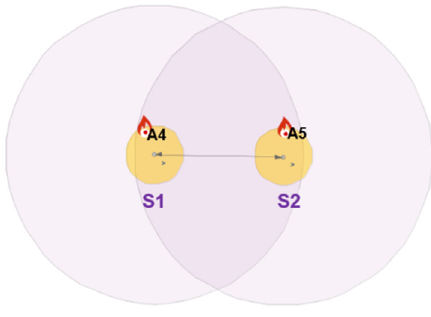
Figure 4. Simulation setup in CupCarbon.